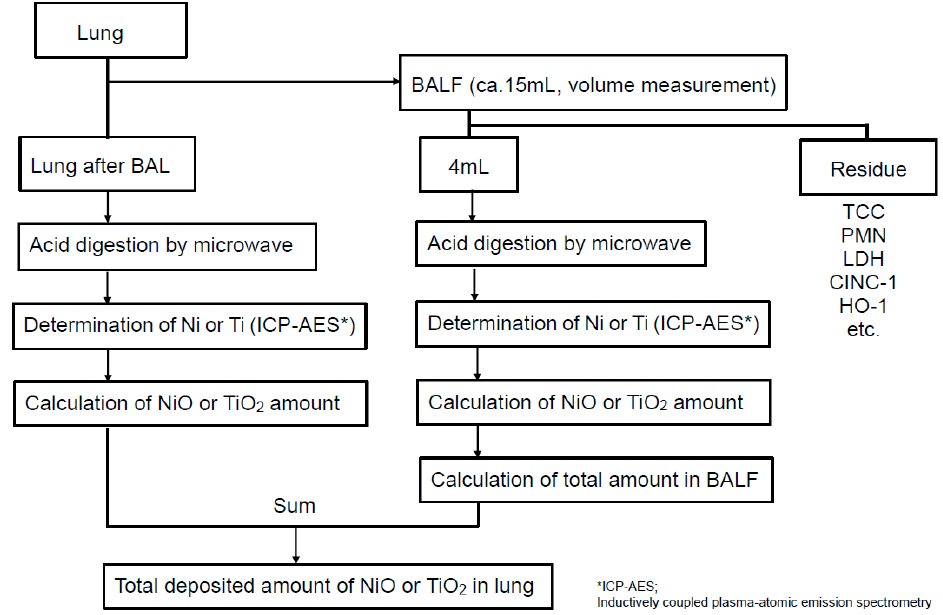
Figure 6. Determination method of NiO or TiO 2 in lung.